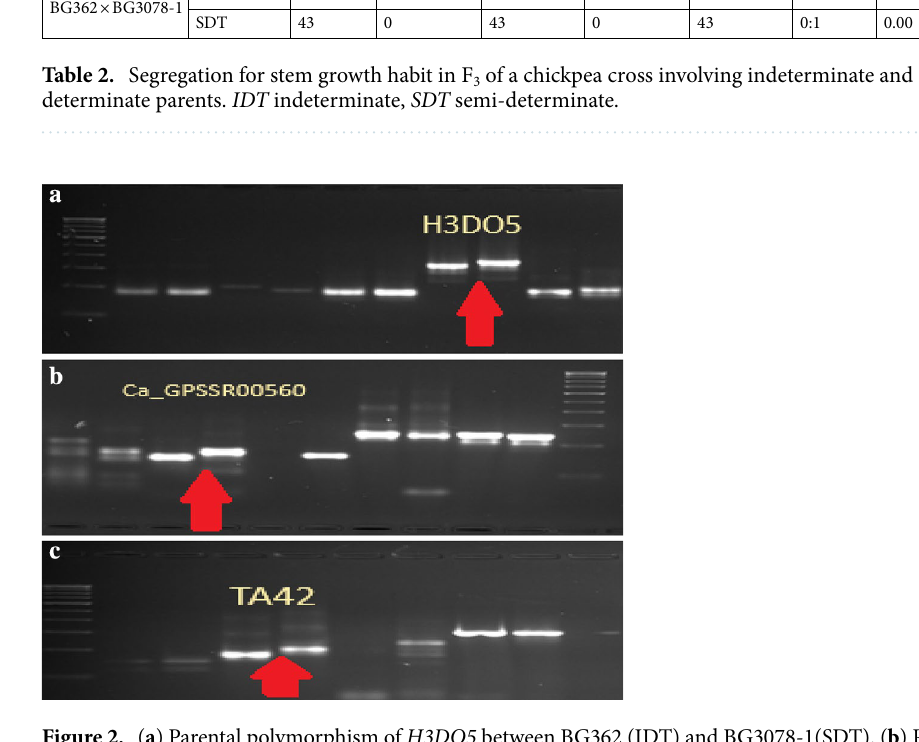
Phenotypic class